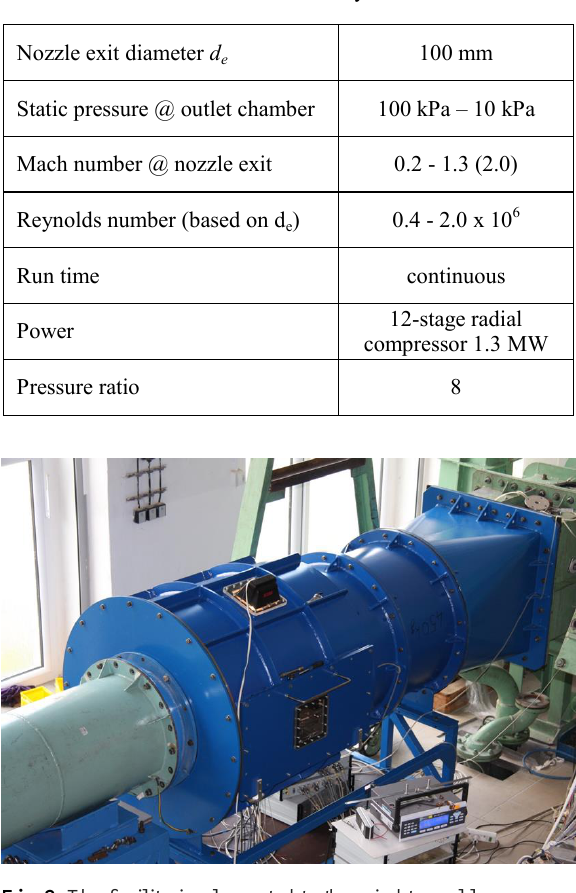
Table 1. Calibration facility main data.